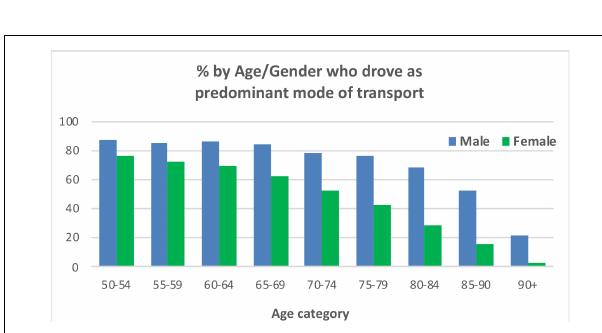
FIGURE 2 | Percentage of participants across Age and Gender who drove themselves as their predominant mode of transport.